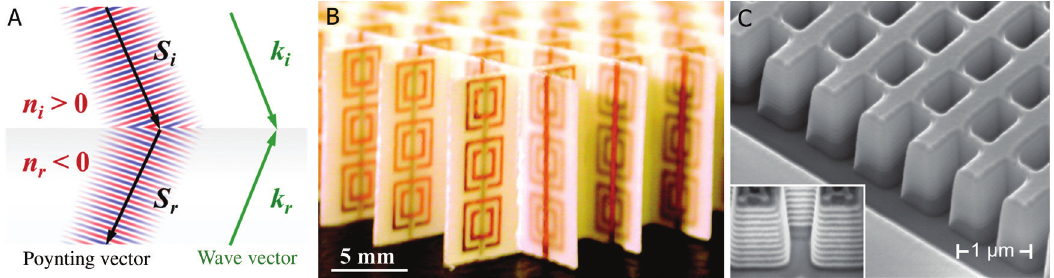
Figure 3 (A) Illustration of negative refraction when light is incident from a positive-index material to a negative-index material. Note in the (cid:31) (cid:31) negative-index material, the wave vector are antiparallel. The wave patterns (in blue and red) are from a full- ( ) k and Poynting vector ( ) S wave simulation. (B) Photograph of a negative-index metamaterial working at microwave frequencies, which consists of copper wires and SRRs. (C) Scanning electron micrograph of a 3D fishnet structure to realize bulk NIMs at optical frequencies. The inset shows alternating layers of 30 nm of silver (Ag) and 50 nm of magnesium fluoride (MgF ). (B) and (C) are adopted from Refs. [33] and [34], respectively, with 2